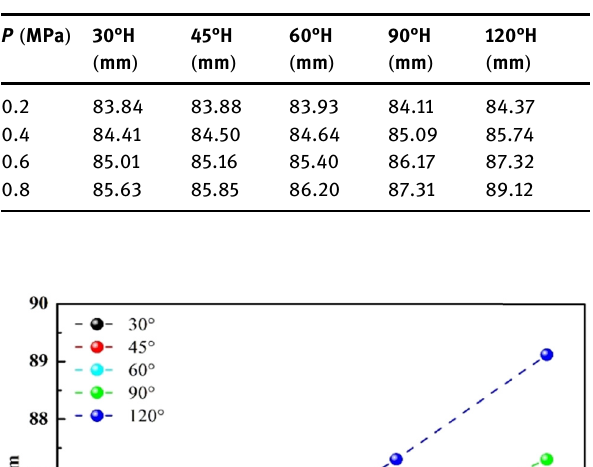
Table 3: Coordinates of maximum deformation height points of centerbody at di ff erent angles